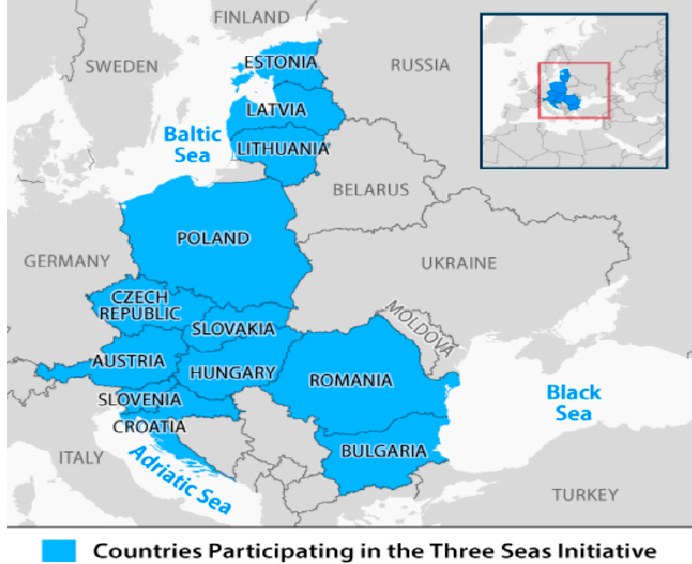
Figure 2. The Three Seas Initiative’s countries (source: Garding, Mix [16]).